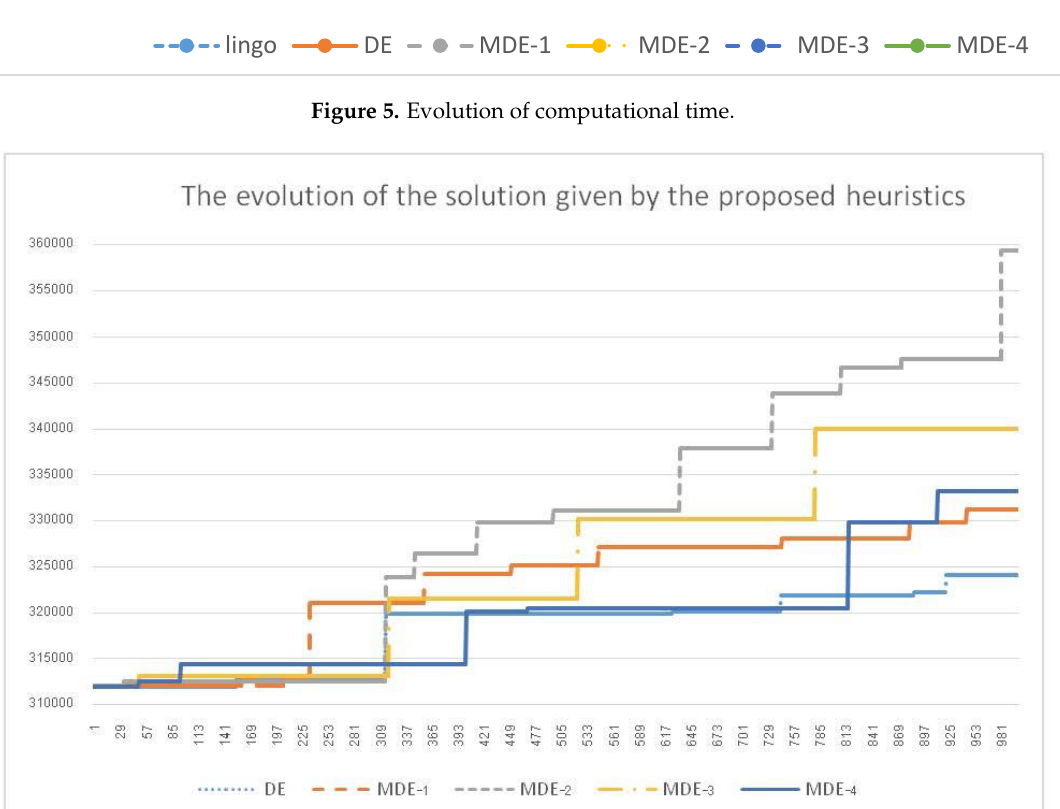
Figure 5. Evolution of computational time.